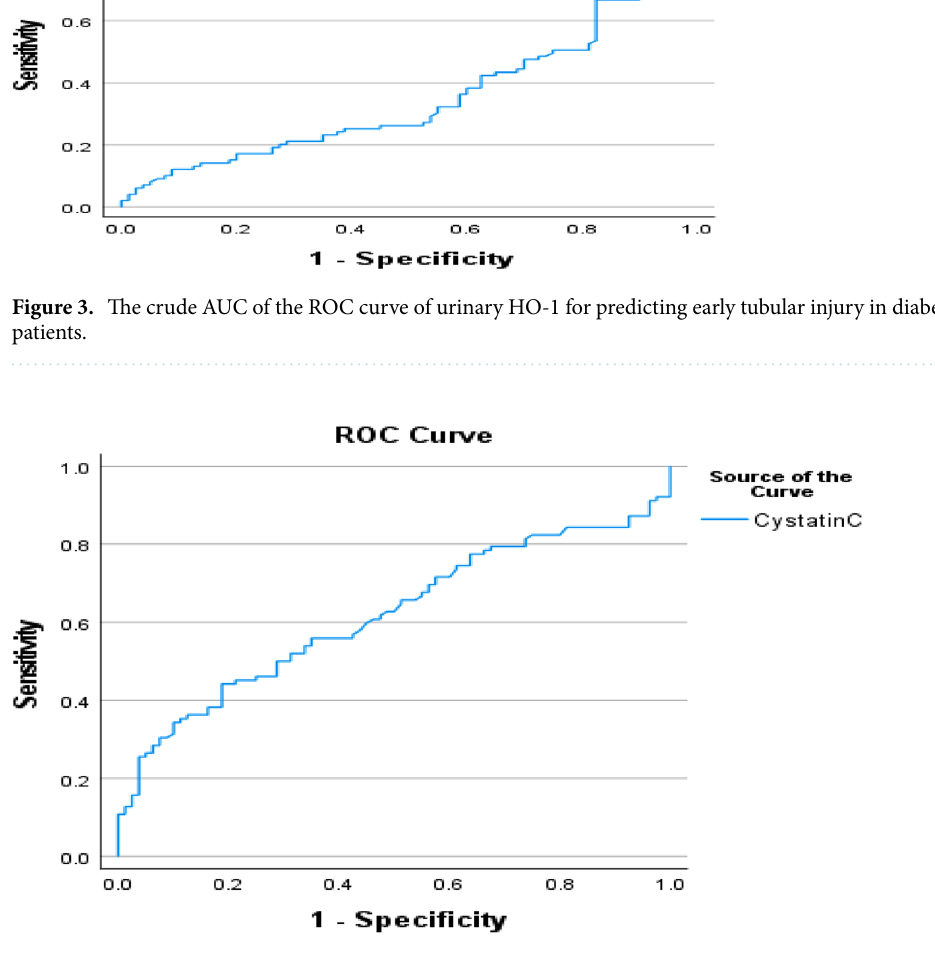
Figure 4. The crude AUC of the ROC curve of serum cystatin-c for predicting early tubular injury in diabetic